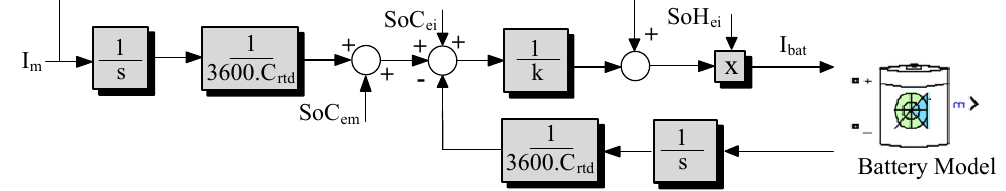
Figure 19. Advanced SoC diagram block.